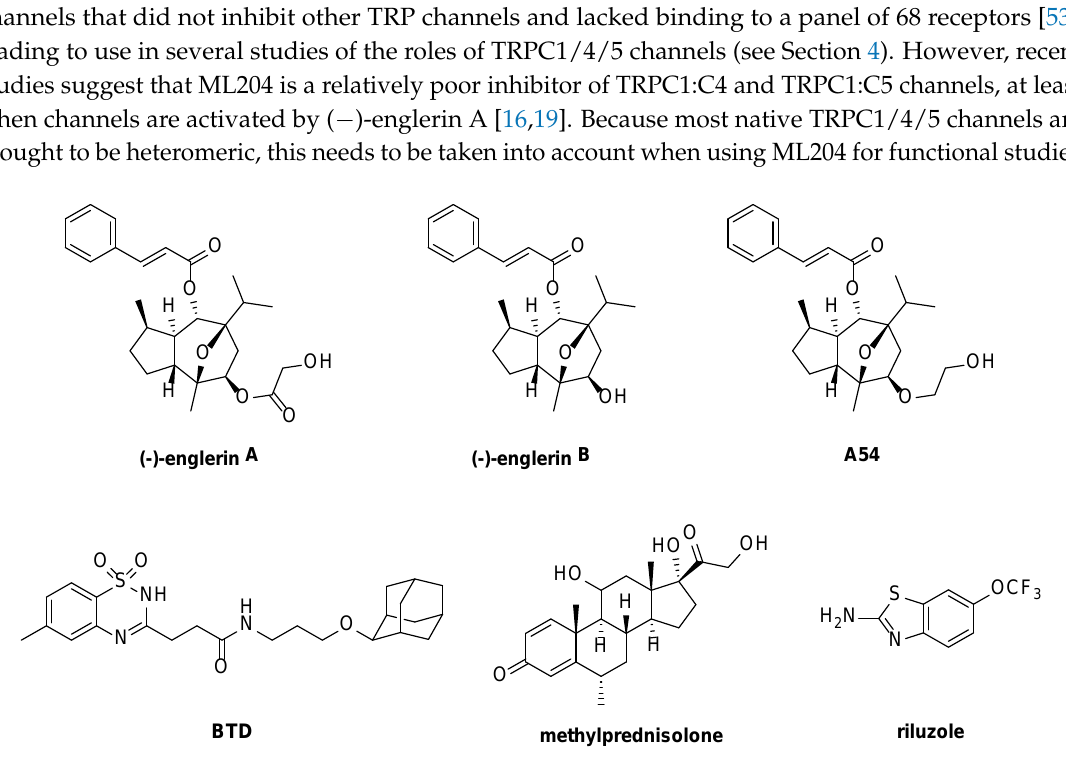
Figure 3. Structures of recently reported TRPC1/4/5 activators, the ( − )EA metabolite ( − )EB, and the (−)EA antagonist A54.